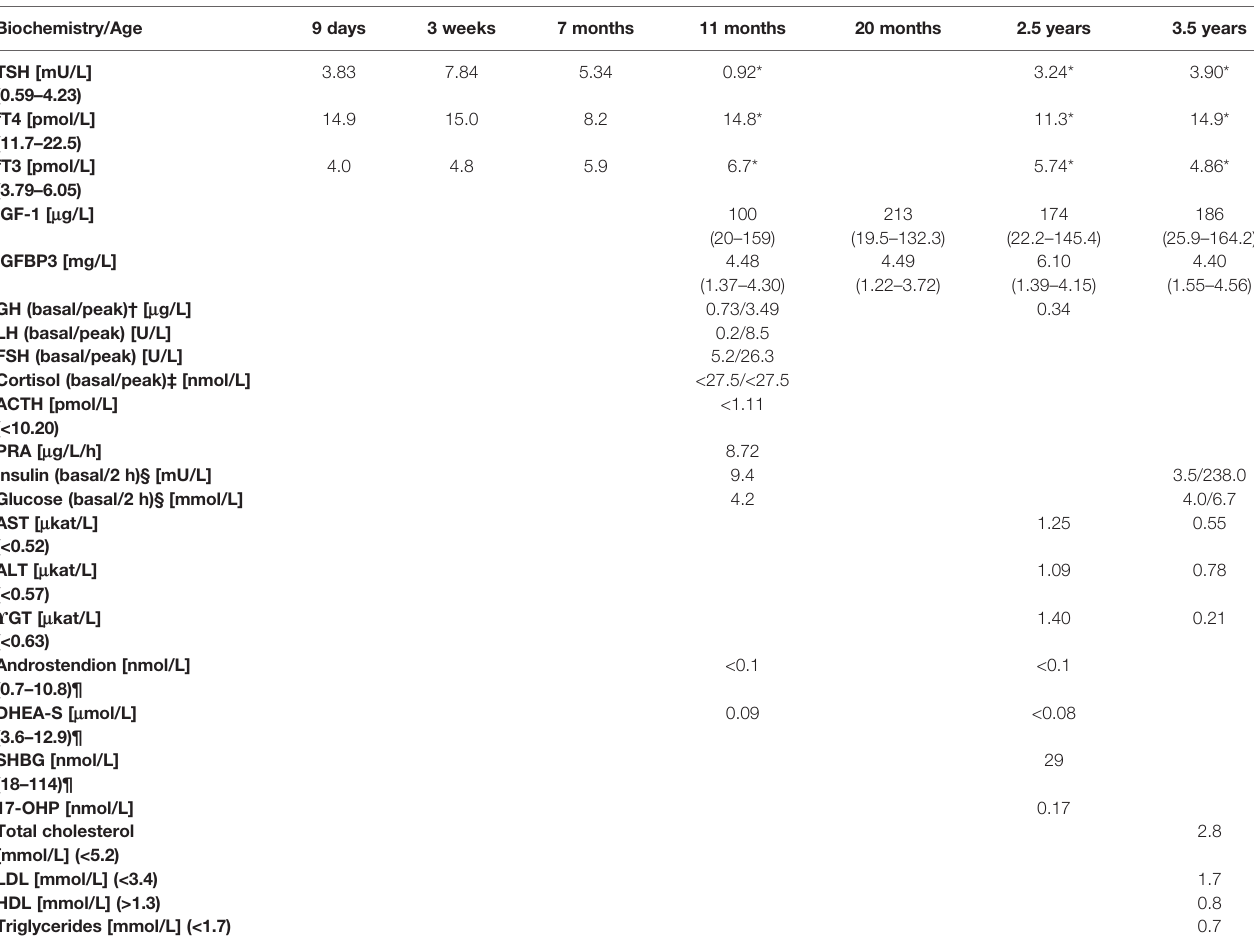
TABLE 3 | Laboratory values of case patient